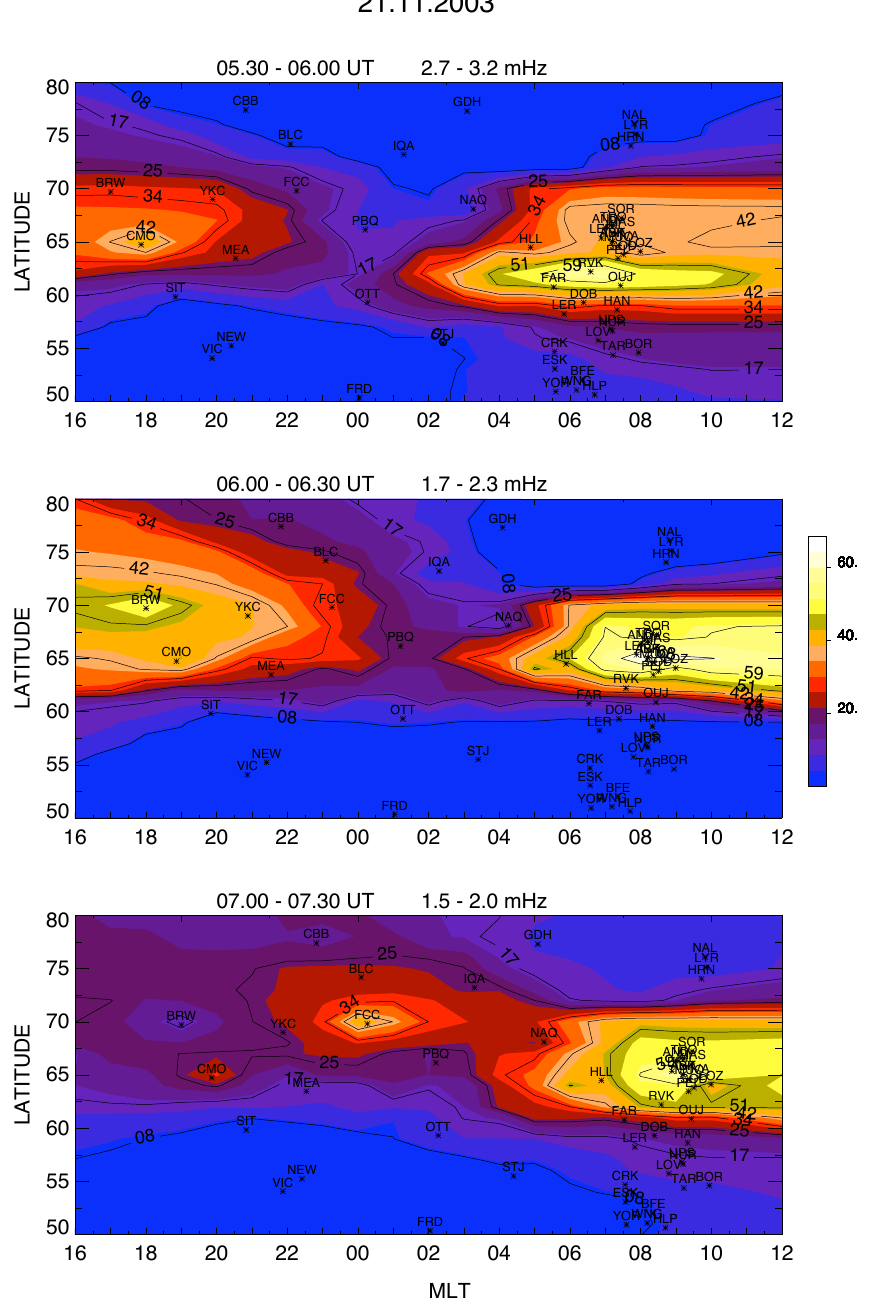
Fig. 10. Distribution maps ( 8 -MLT diagram) of Pc5 magnetic pulsations calculated for three time intervals (indicated on the top of each map) on 21 November 2003 by using the data from 64 ground stations located at the geomagnetic latitudes 8 =50–80 ◦ .